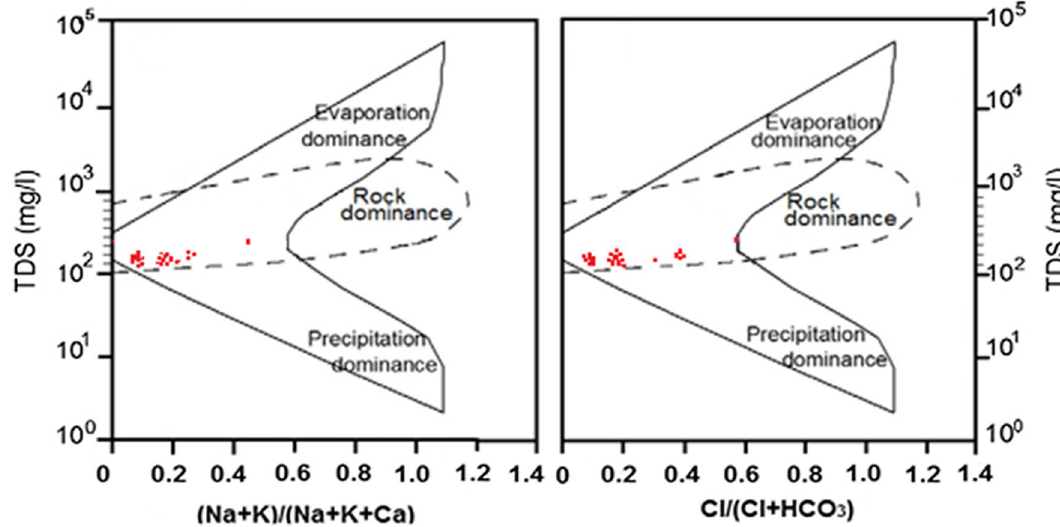
Fig. 3 Gibbs ratio for groundwater in pre-monsoon